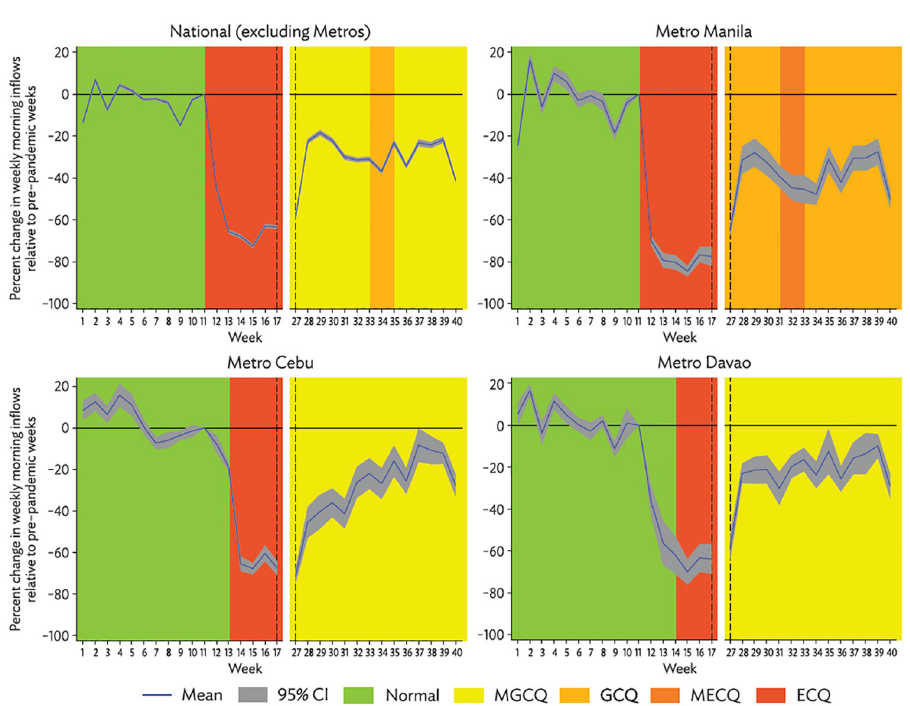
Fig 4. Subnational mobility response to imposition of enhanced community quarantine. CI = confidence interval; ECQ = enhanced community quarantine; GCQ = general community quarantine; MECQ = modified enhanced community quarantine; MGCQ = modified general community quarantine. Source: Authors’